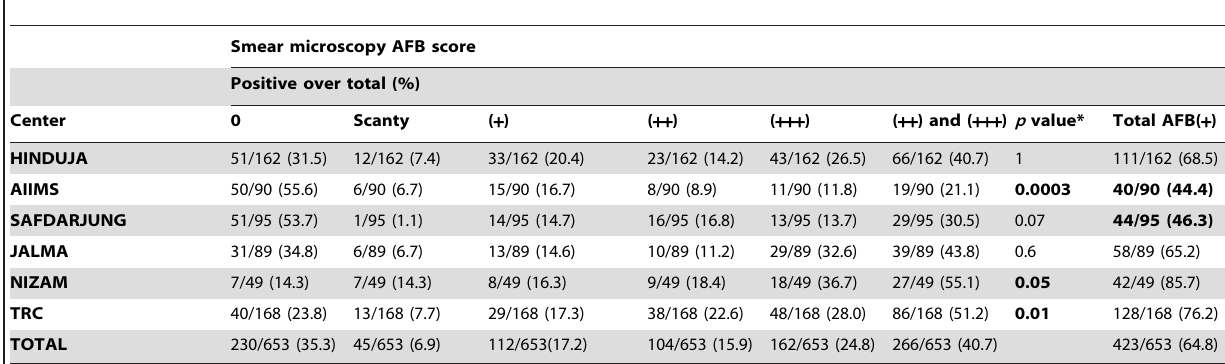
Table 7. Comparative proportions of the semi-quantitative smear microscopy results (AFB score) obtained in groups of patients with active pulmonary TB enrolled at the different centers independent of their HIV-status.